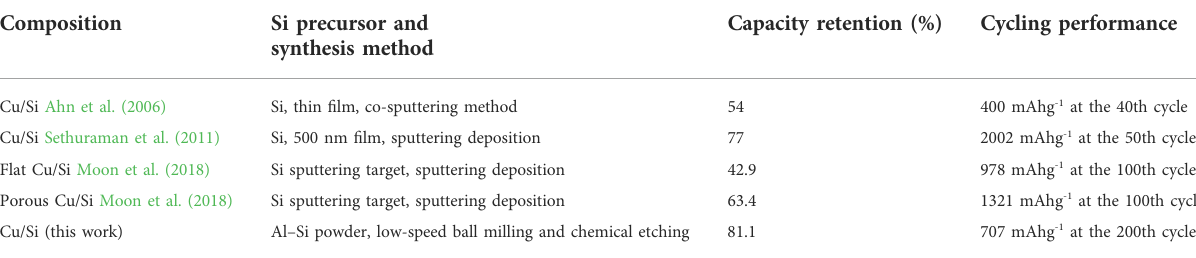
TABLE 1 Comparison between previously published works on Si/Cu composite anode materials for Li-ion batteries and the present results. Composition Si precursor and synthesis